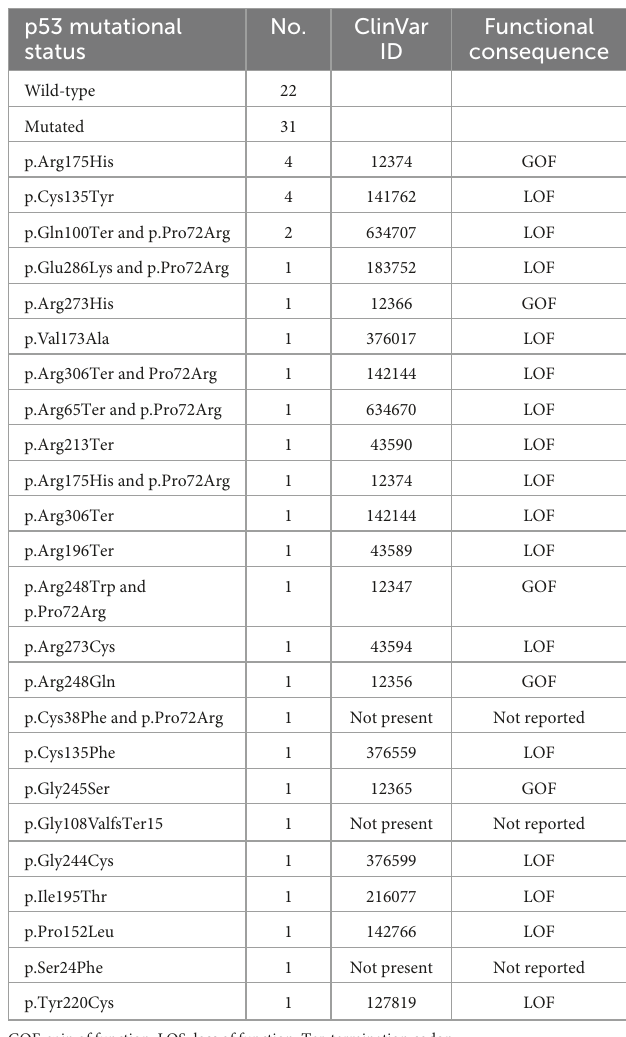
TABLE 6 p53 mutational